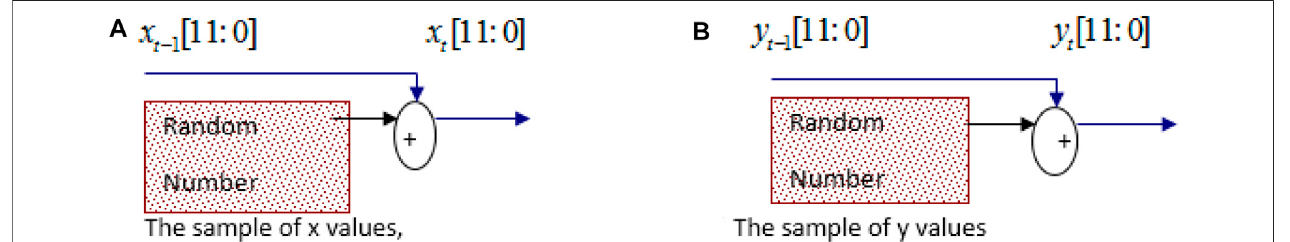
FIGURE 9 | Sampling unit. (A) The sample of x values (B) The sample of y values.